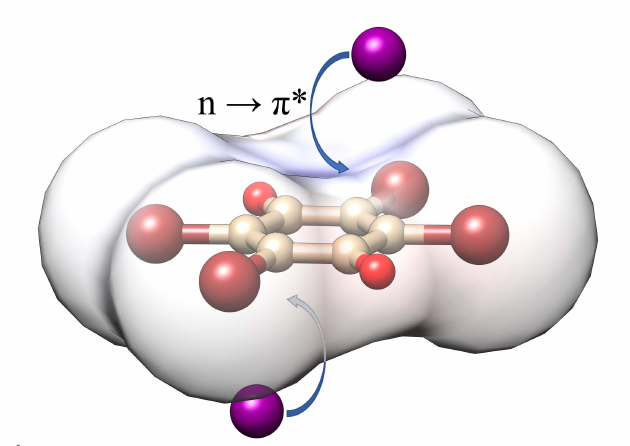
Figure 1 Iodide–quinone n (cid:2)(cid:2)(cid:2) (cid:2) -hole interactions in the co-crystal of 3-chloro- N - methylpyridinium iodide with tetrabromoquinone